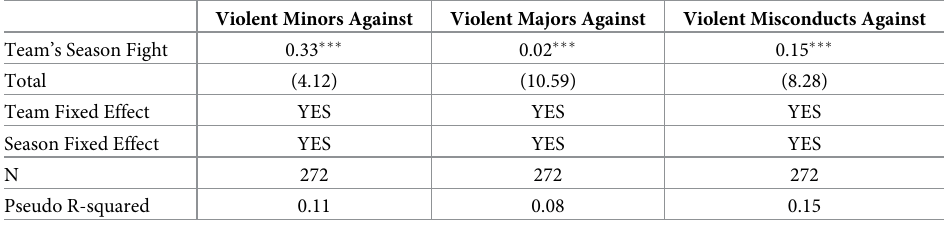
Table 1. Marginal effect of season fights on season penalties against.